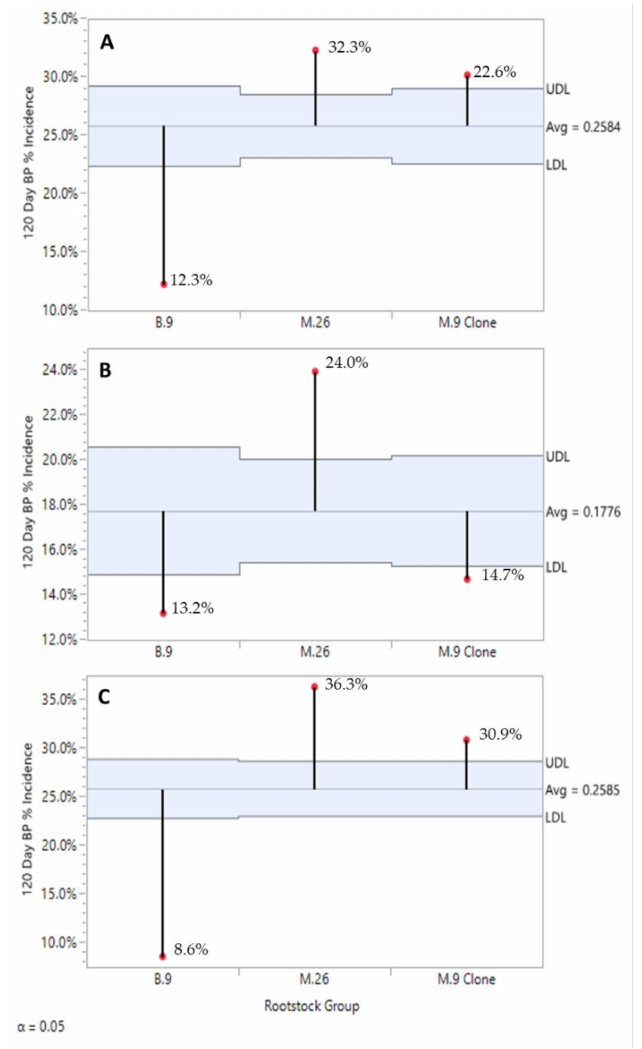
Figure 4. Rootstock effect on ‘Honeycrisp’ bitter pit incidence after 120 days of refrigerated storage in 2016 ( A ), in 2017 ( B ), and in 2018 ( C ) with both regions combined. JMP Fit XY Platform, Analysis of Means of Proportions of the binomial dataset, alpha =